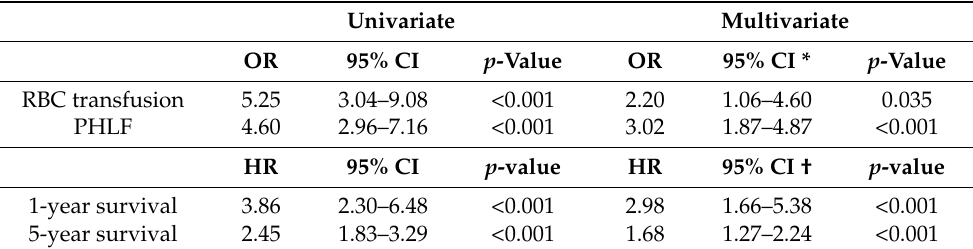
Table 4. Transfusion and surgical outcomes adjusted by preoperative PNI level (<44).